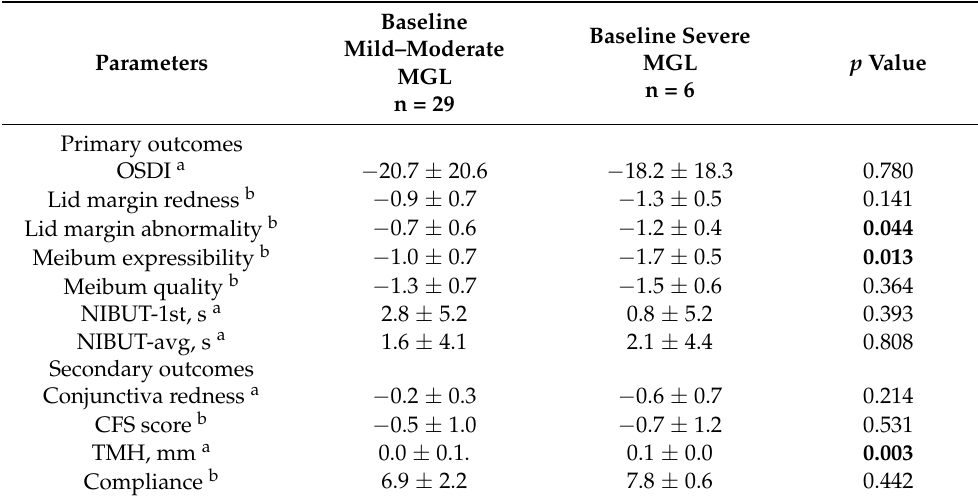
Table 3. Comparison of improvements in ocular surface parameters after 2 weeks treatment according to the baseline meibomian gland loss in the hypochlorous acid (HOCL) group.